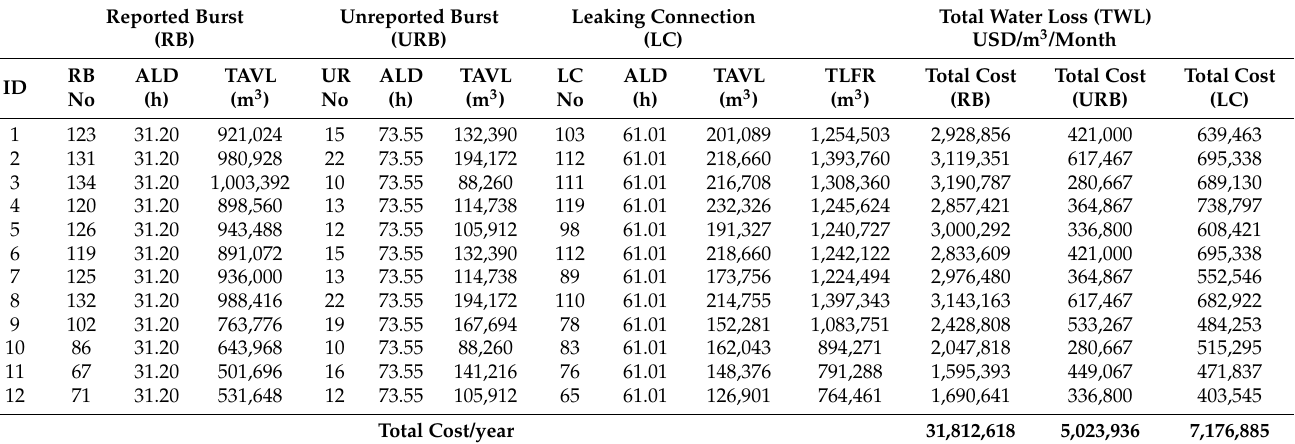
Table 5. Total costs of infrastructure leakage quantities